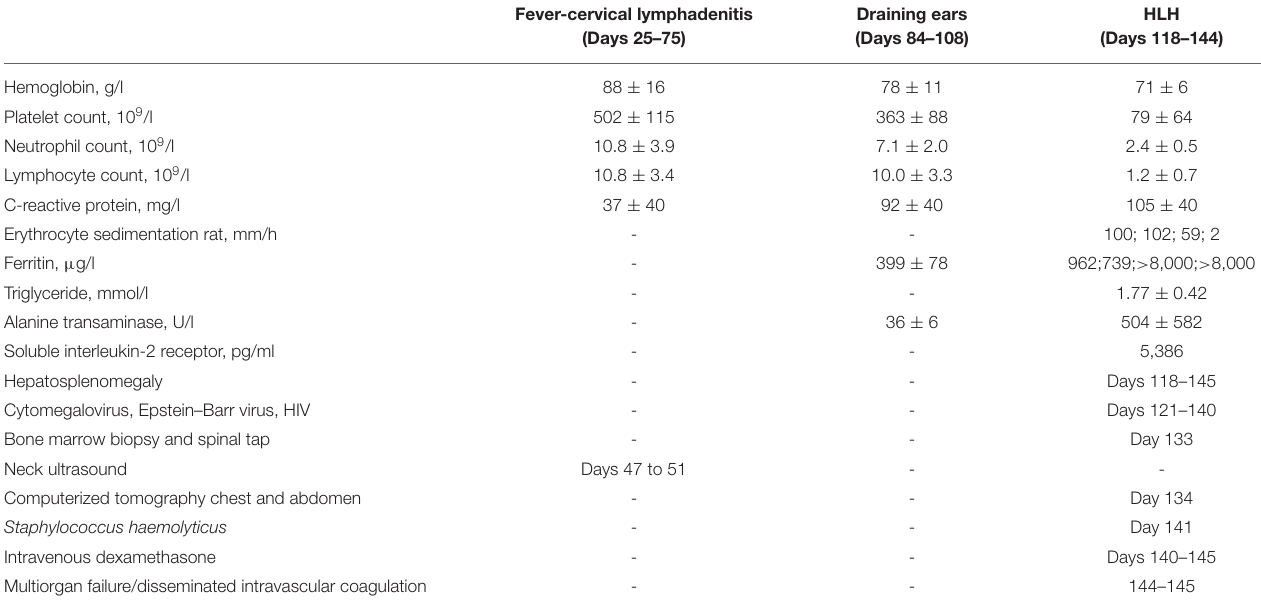
TABLE 1 | Diagnostic-treatment timeline for his inpatient periods; values are mean ±